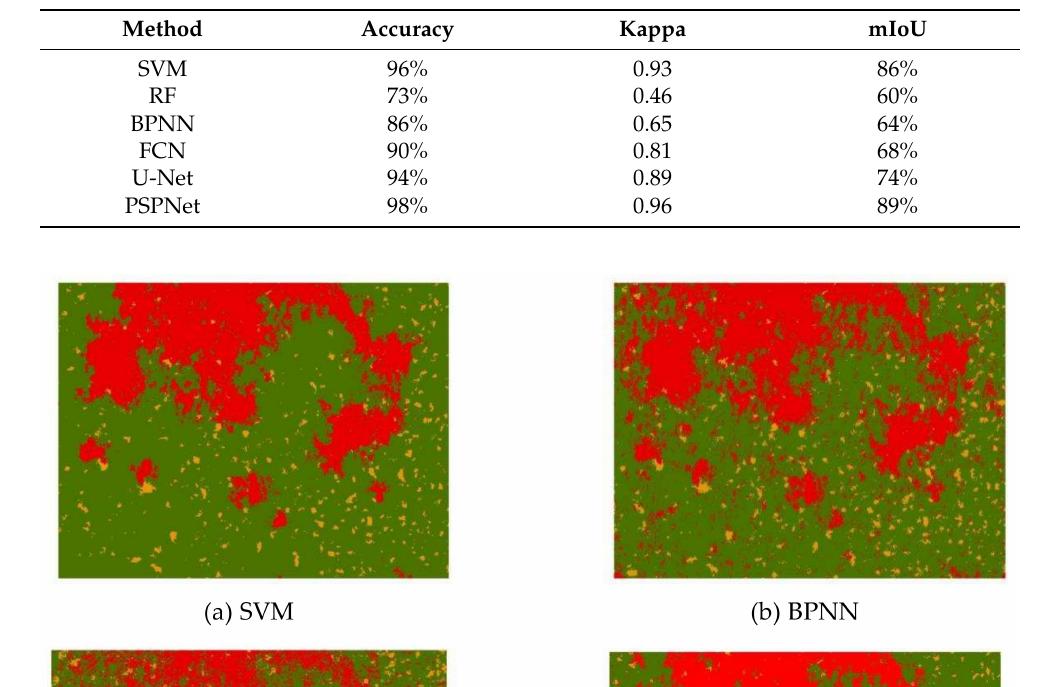
Table 1. Classification performance of the SVM, RF, BPNN, FCN, U-Net, and PSPNet algorithms.